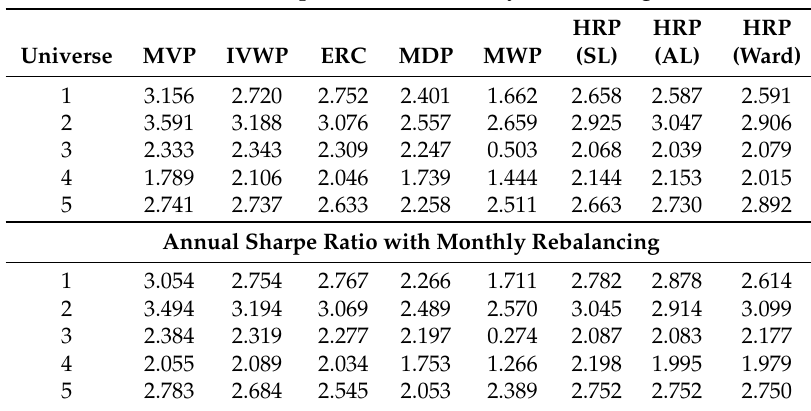
Table 11. The out-of-sample realized annual Sharpe ratio for the portfolios considered when they were rebalanced daily.